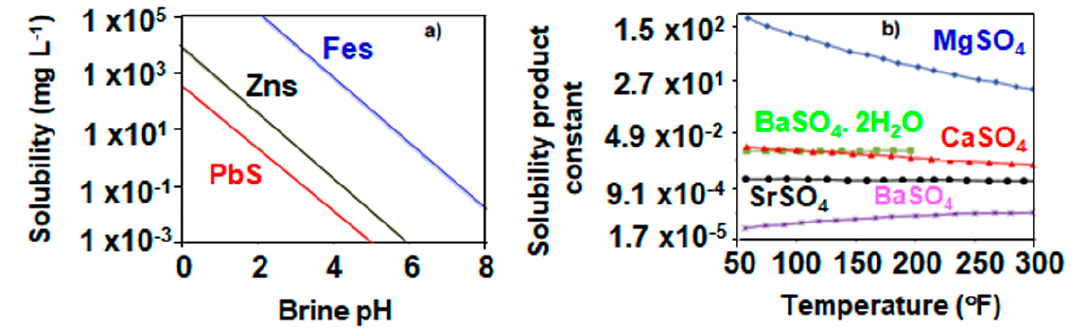
Figure 1. ( a ) Solubility vs. pH curves of different sulfide scales in 1M NaCl at 25 °C. ( b ) Solubility of sulfate scale.